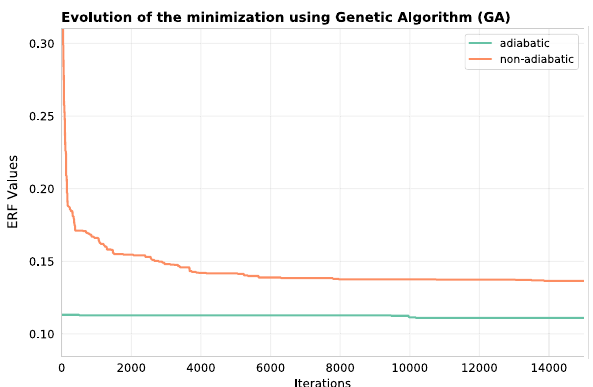
Fig. 17 Comparison between adiabatic and standard minimization using the Genetic Algorithm (GA). The adiabatic minimization reaches stability faster while the standard minimization approach has not con- verged yet even at 15,000